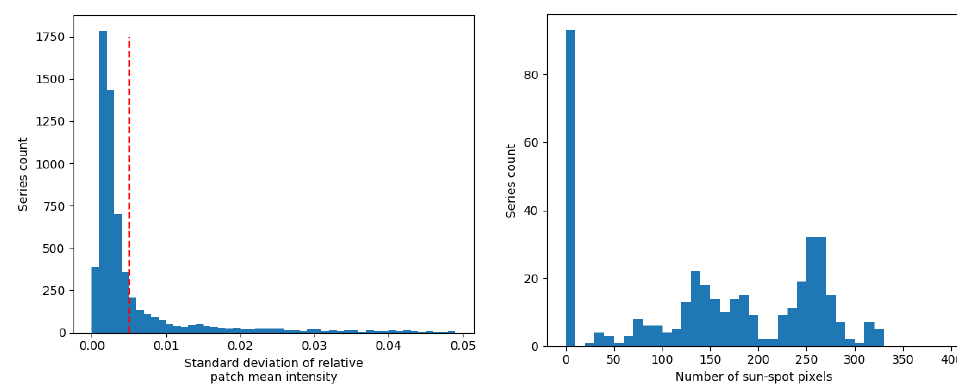
Figure 7. Distribution of relative standard deviations of mean intensities ( left ) and the detected number of sun-spot pixels ( right ) for the series acquired by SUTO-Solar. Red dashed line in the left plot indicates the threshold for series affected by cloud